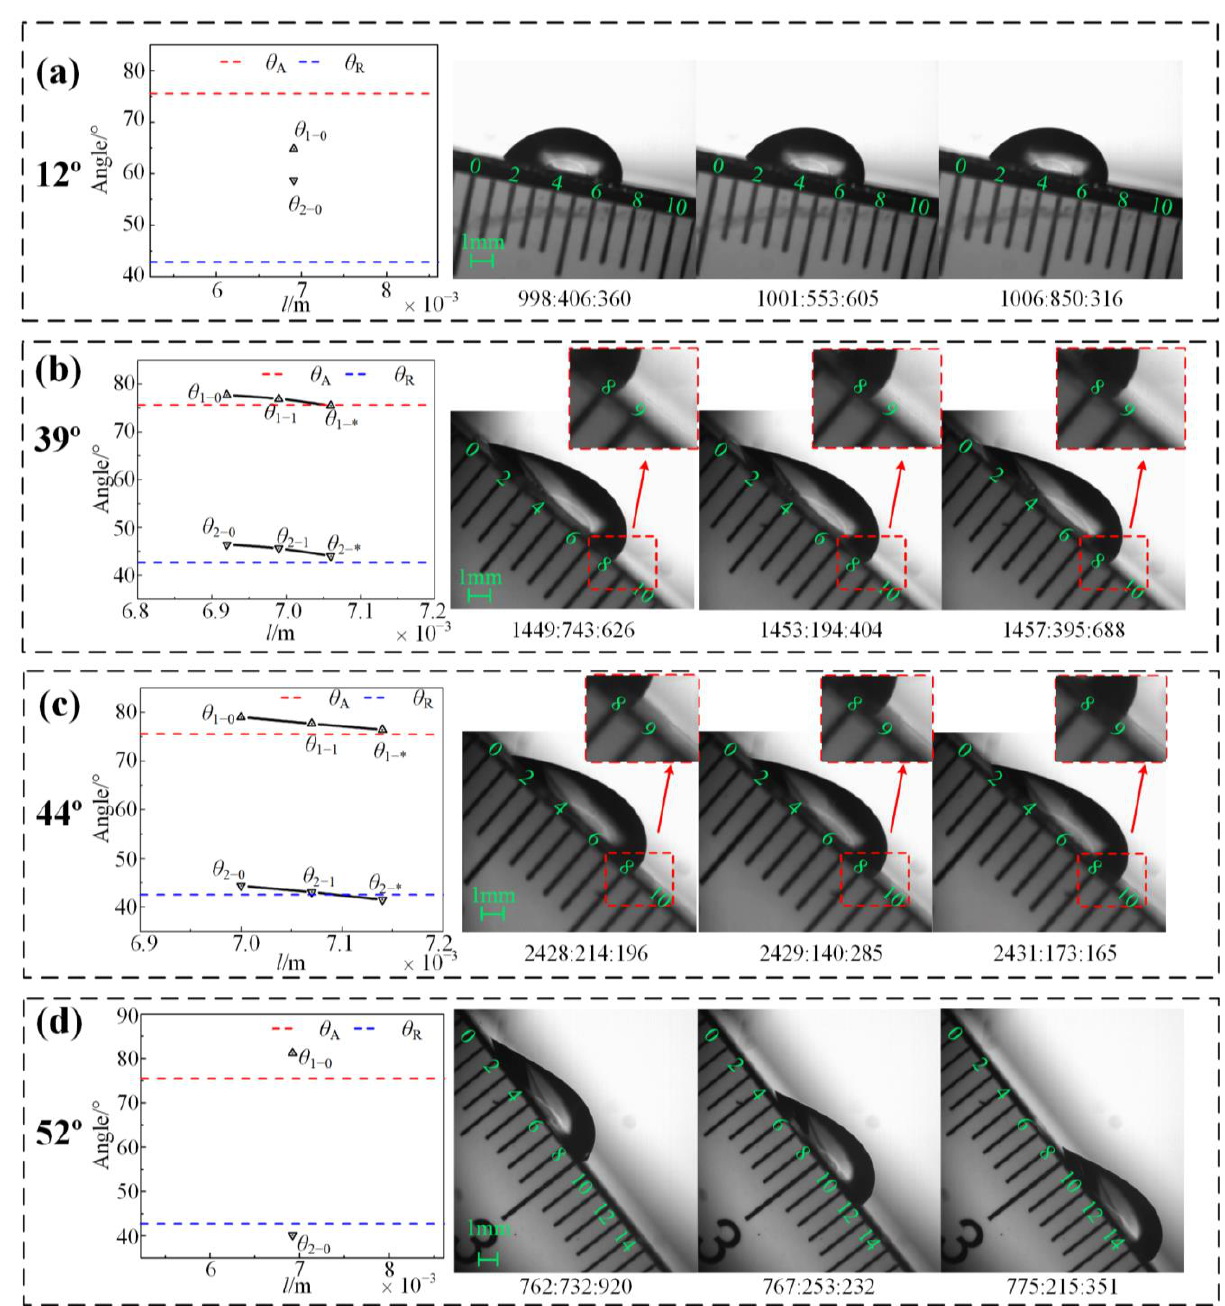
Figure 11. The simulations, predictions, and experiments of droplets on an inclined rough SiO 2 surface. The microstructure parameters are d = 6 μm, h = 12 μm, and a = 60 μm; V = 40 μL. ( a ) 12°, ( b ) 39°, ( c ) 44°, and ( d ) 52°.